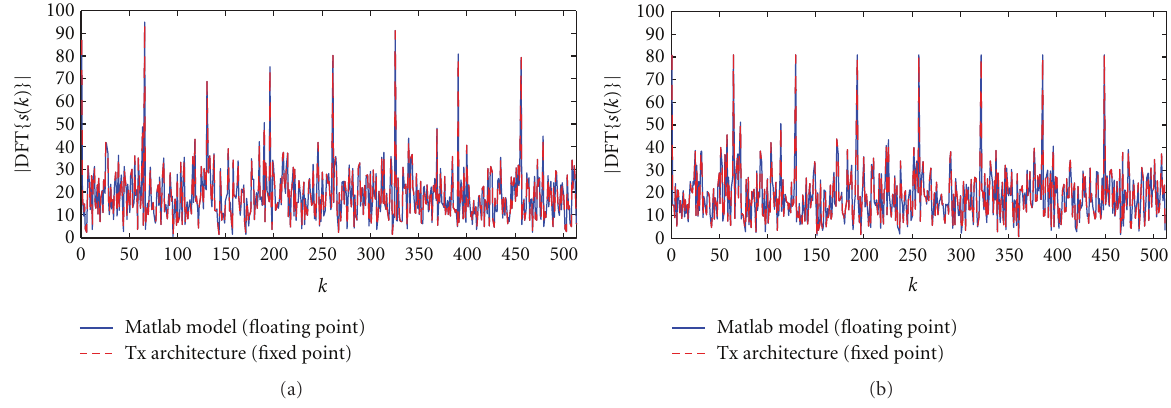
Figure 12: Discrete Fourier transform of the s ( k ) sequence generated by the transmitter architecture. (a) ST mode; (b) DDST mode.